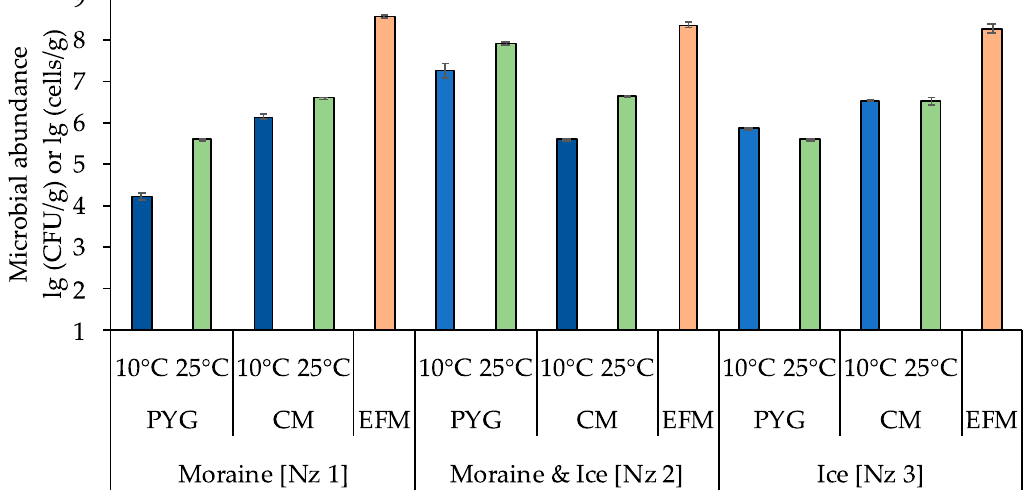
Figure 2. Total numbers of prokaryotic cells and numbers of culturable cells in the samples. The blue columns indicate the communities incubated at 10 °C, the green columns indicate the communities incubated at 25 °C, the orange columns indicate the total numbers of prokaryotic cells obtained by epifluorescence microscopy. PYG—peptone yeast glucose medium, CM—modified Czapek medium, EFM—the total numbers of prokaryotic cells obtained by epifluorescence microscopy. Error bars are corresponding with the 95% confidence limits.